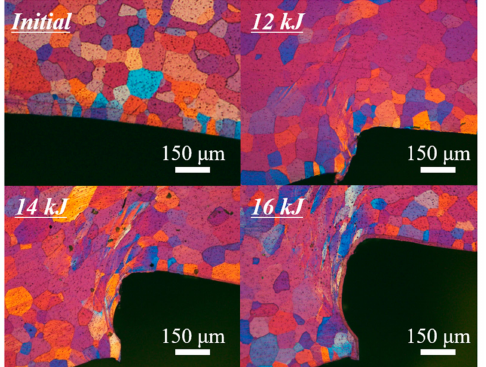
Figure 15. Local enlargements of the shearing area of position D under different discharge